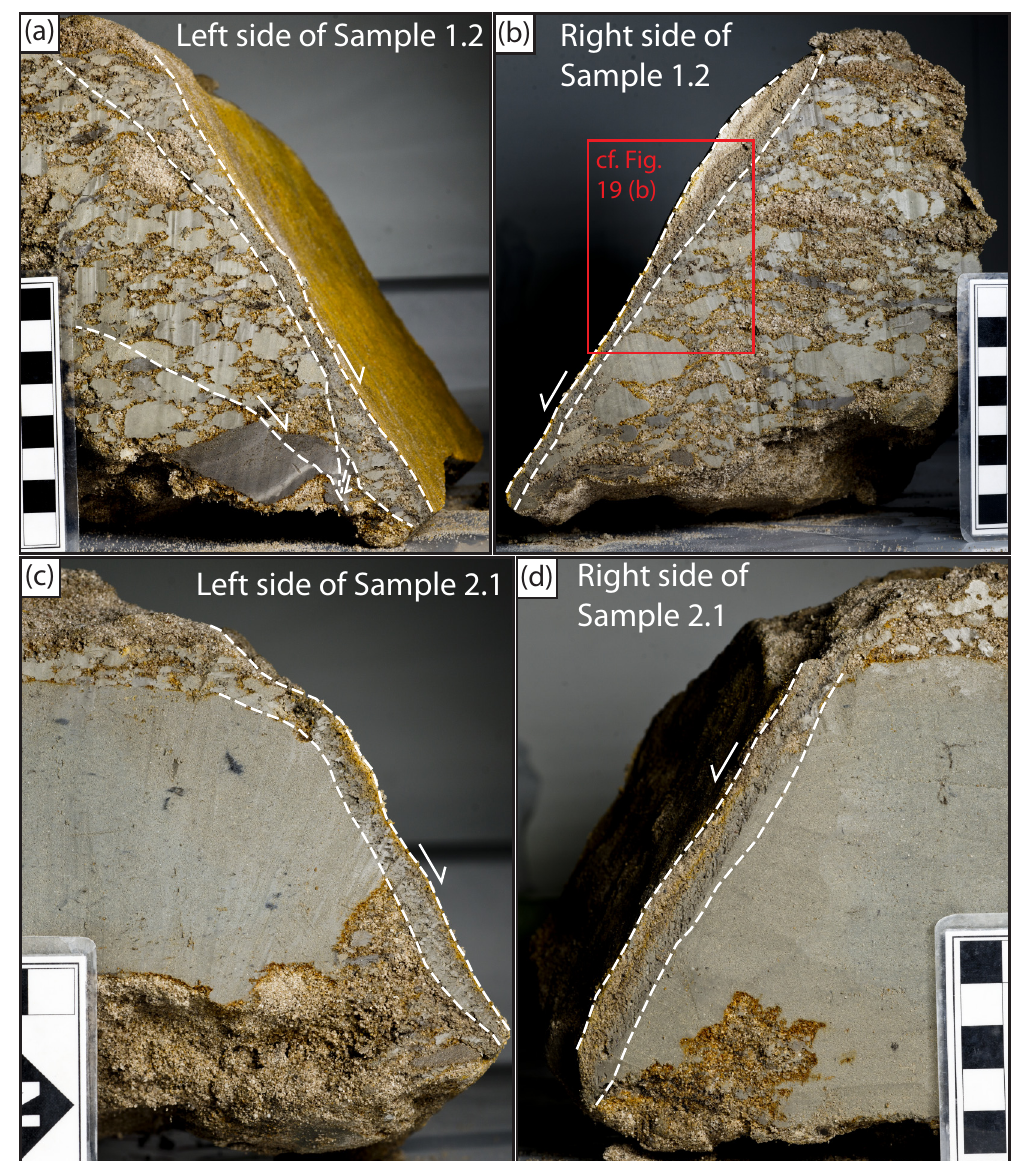
Figure 12. Cleaned samples extracted from profiles 1.2 and 2.1. Each sample has a width of about 20cm. (a) and (b) show both sides of sample 1.2; (c) and (d) show both sides of sample 2.1. Dashed lines indicate the shear zone boundaries. Note the increasing amount of grain-scale mixing with greater distance of the source clay. Red rectangle marks the detail shown in Fig.